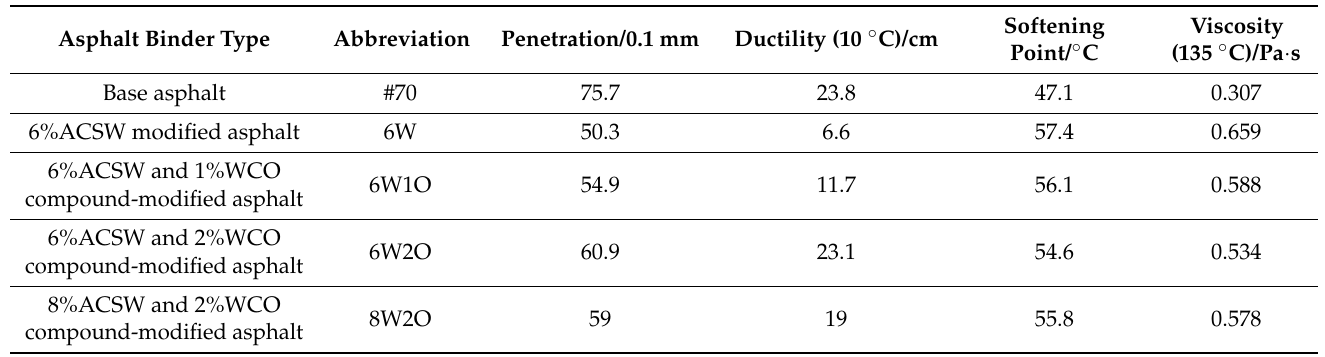
Table 5. The abbreviations and physical properties of different types of asphalt binders.